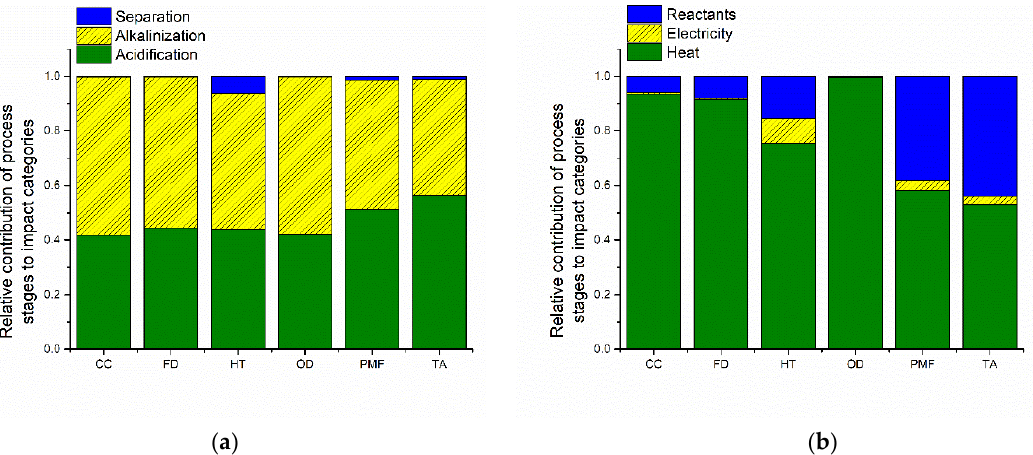
Figure 8. The relative contribution of process stages and inputs to the evaluated impact categories in LCA results obtained for the conditioning stage in glucose production from woody biomass residues. ( a ) Impact aggregation by sub-process; ( b ) impact aggregation by input.